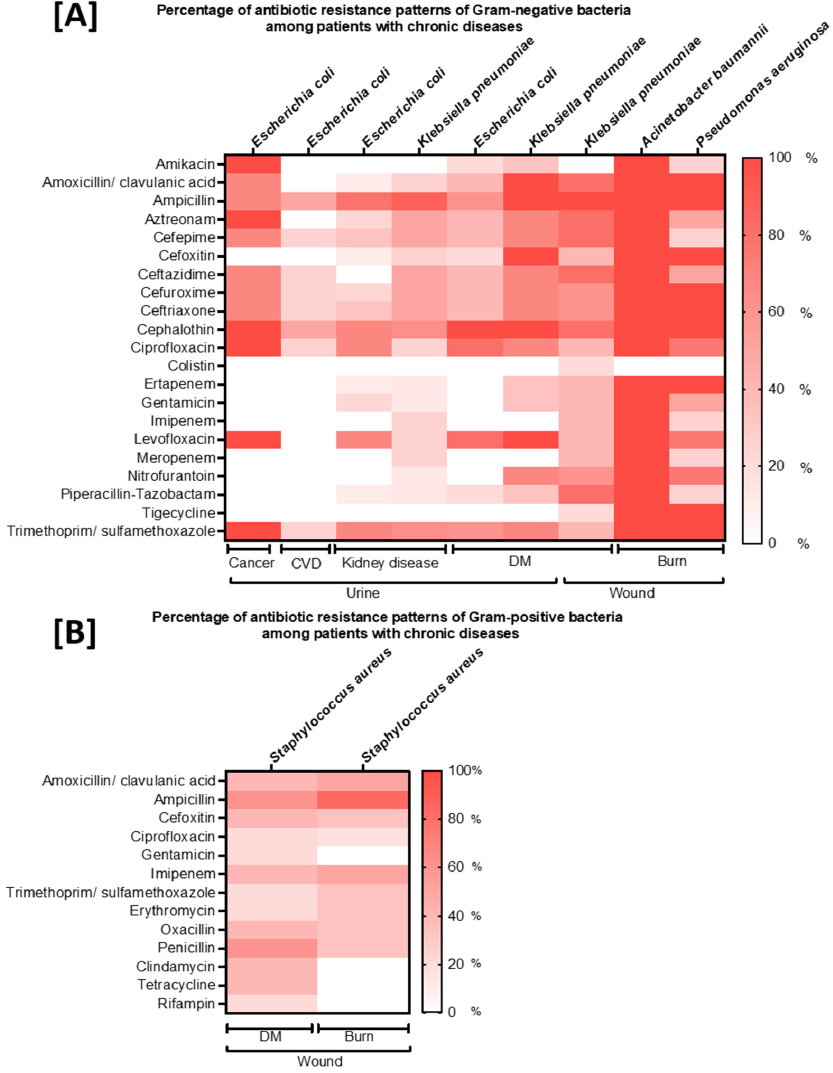
Figure 1. Heat maps of antibiotic resistance profiles. ( A ) Resistance profile of Gram-negative bacte- ria ( Escherichia coli, Klebsiella pneumoniae, Acinetobacter baumannii, and Pseudomonas aeruginosa) associated with patients suffering from cancer, cardiovascular diseases, kidney disease, diabetes mellitus, and burn) that were detected from urine and wound samples. ( B ) Resistance profiles of Gram-positive bacteria ( Staphylococcus aureus) associated with patients suffering from diabetes mellitus (DM) and burns that were detected from wound specimens. Results are presented based on the red color gradient reflecting the antibiotic resistance rate. The very intense/strong red color indicates the highest (100%) rate of resistance, whereas the absence of the red color was used for the lowest (0%) rate of resistance.